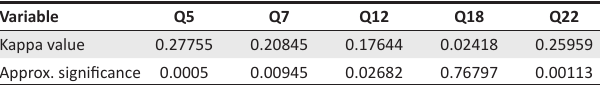
TABLE 4b: Cohen’s kappa measure of agreement.